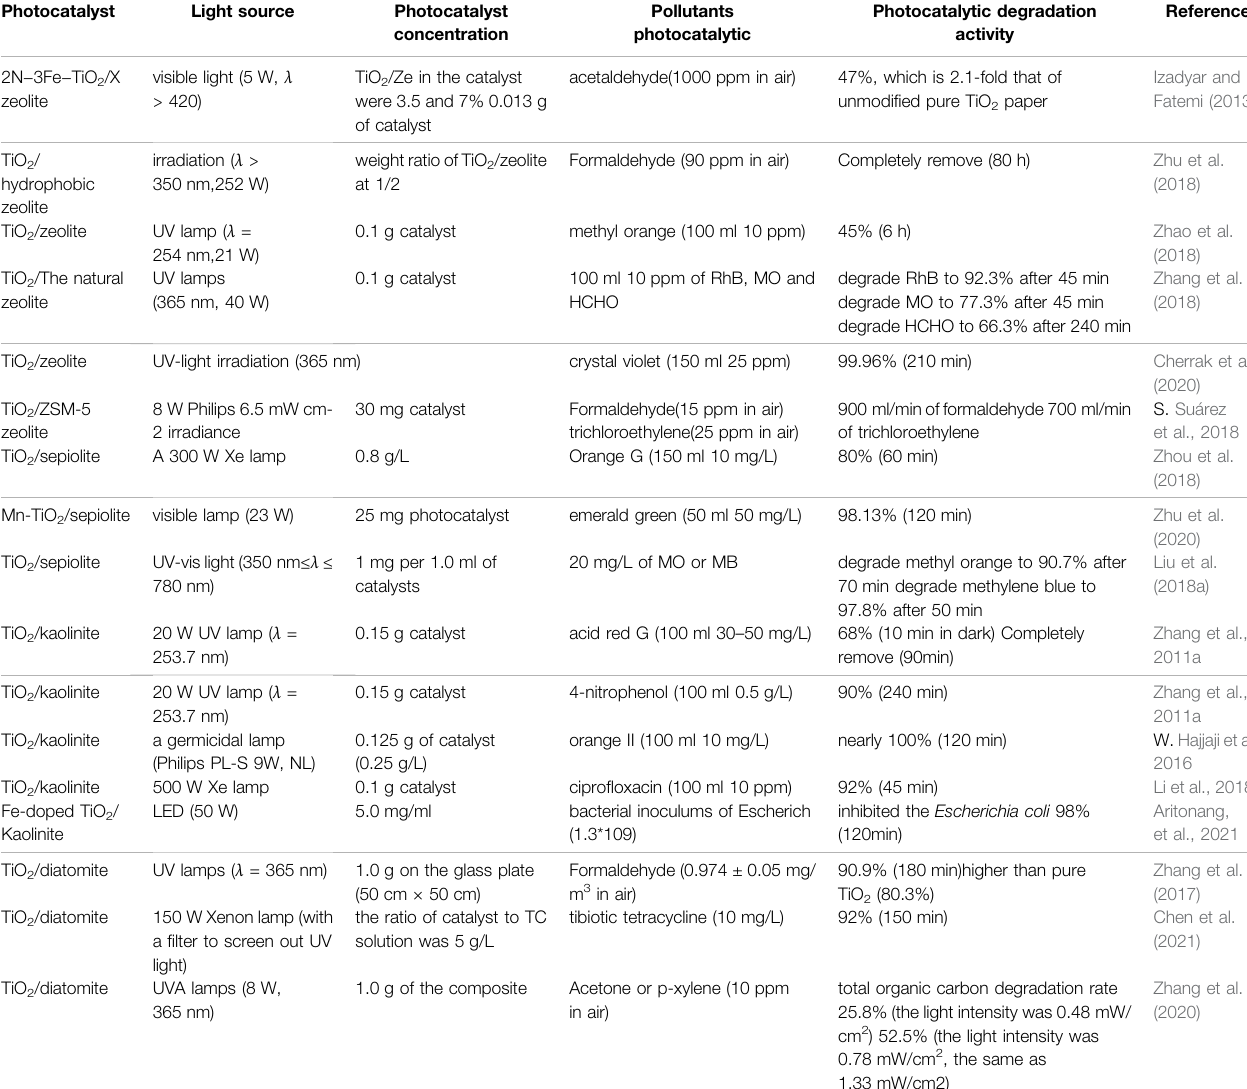
TABLE 1 | Research progress of TiO 2 /non-metallic mineral composite photocatalytic materials in the treatment of pollutant.